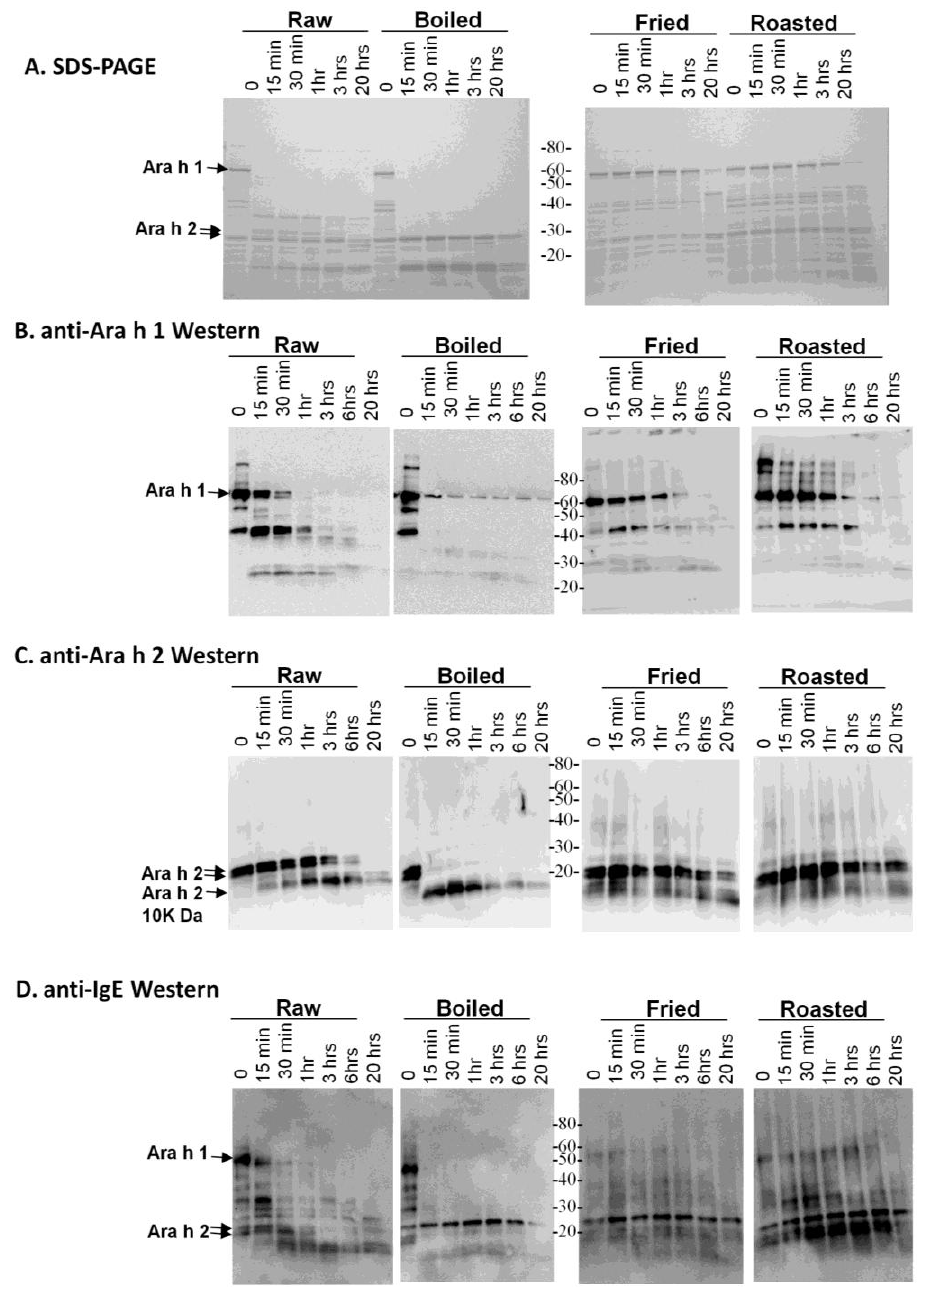
Figure 1. SDS-PAGE and western analysis of the digestion of raw, boiled, fried and roasted peanut extracts with trypsin. Soluble protein extracts from raw, boiled, fried and roasted peanuts were digested with trypsin and subjected to SDS-PAGE ( A ), western blot analysis with anti-Ara h 1 ( B ), western blot analysis with anti-Ara h 2 antibody ( C ) and western blot analysis with pooled human IgE sera from peanut allergic individuals ( D